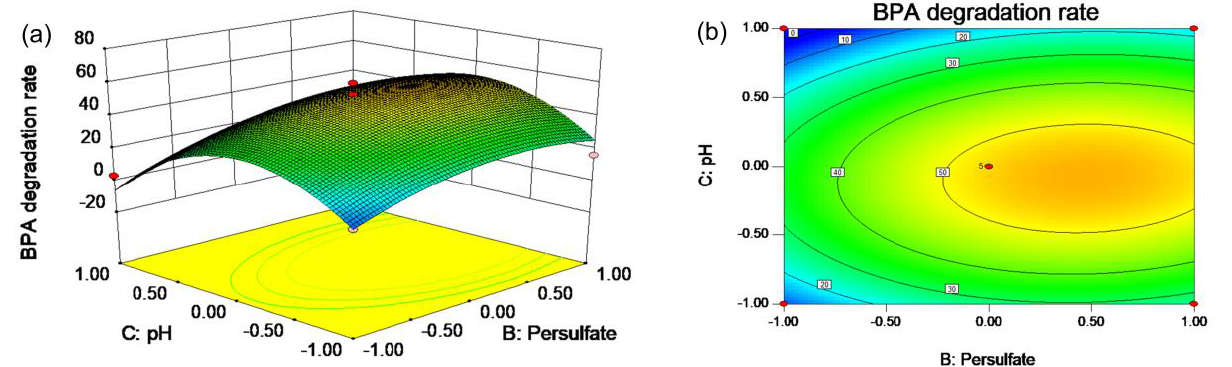
Figure 9. Response surface plot of pH and PS on BPA removal. ( a ) Three-dimensional plot; ( b ) Two-dimensional plot. [BPA] = 5 mg/L, [magnetite] = 0.4 g/L, T = 20 °C.